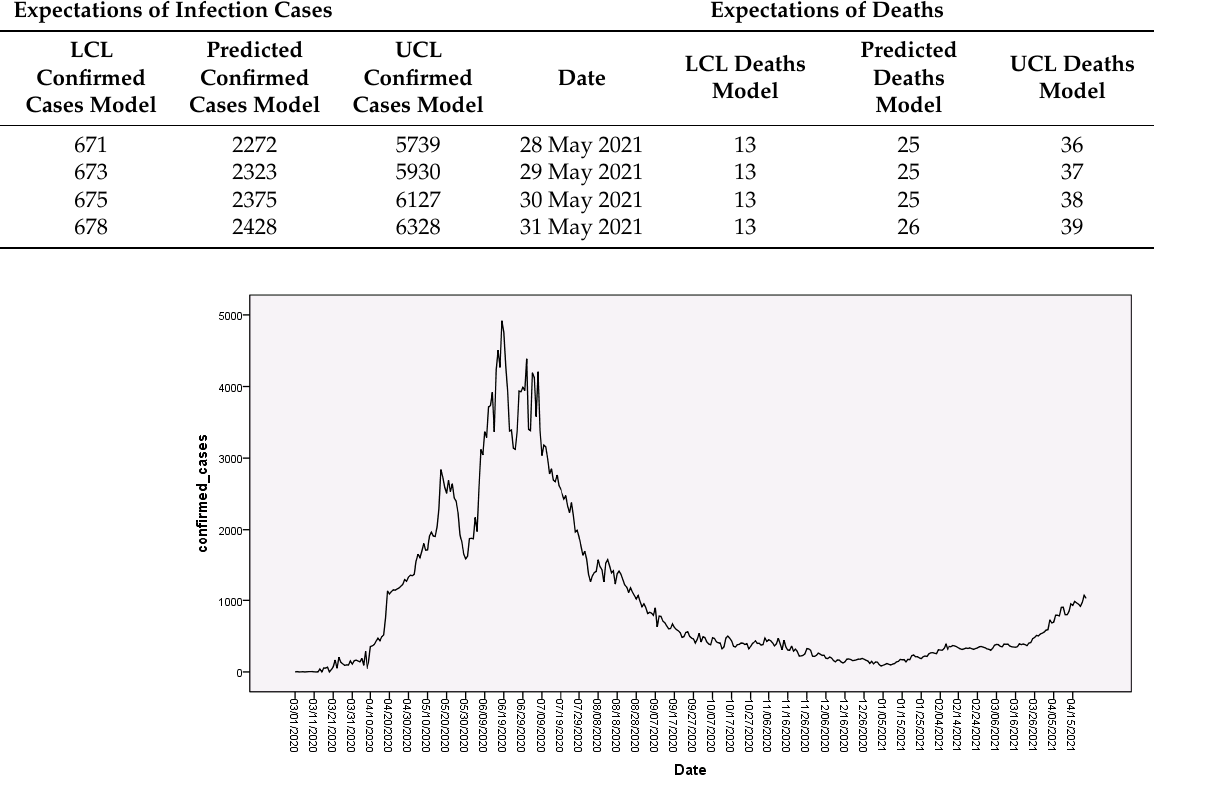
Figure 1. Transmission of confirmed infected cases of COVID-19 in Saudi Arabia for the period from